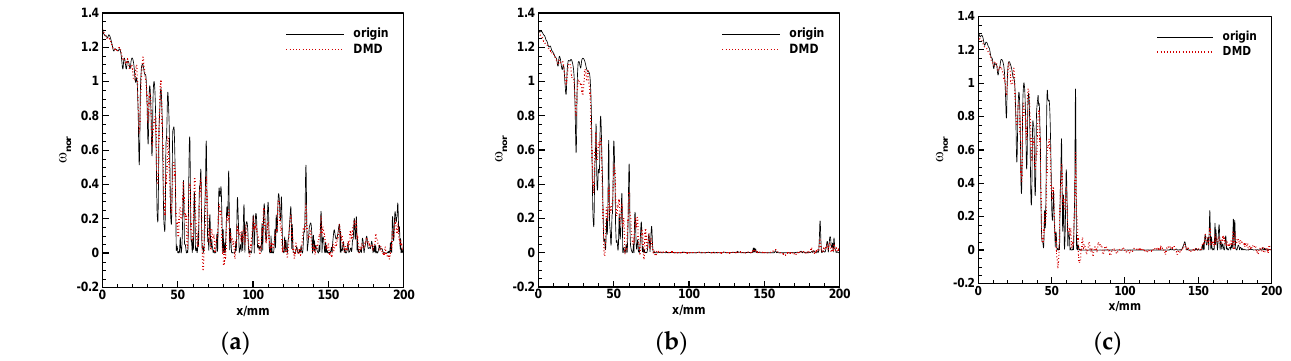
Figure 13. Comparison of original value and DMD reconstruction value of flow field center line: ( a ) case 1; ( b ) case 2; ( c ) case 3.